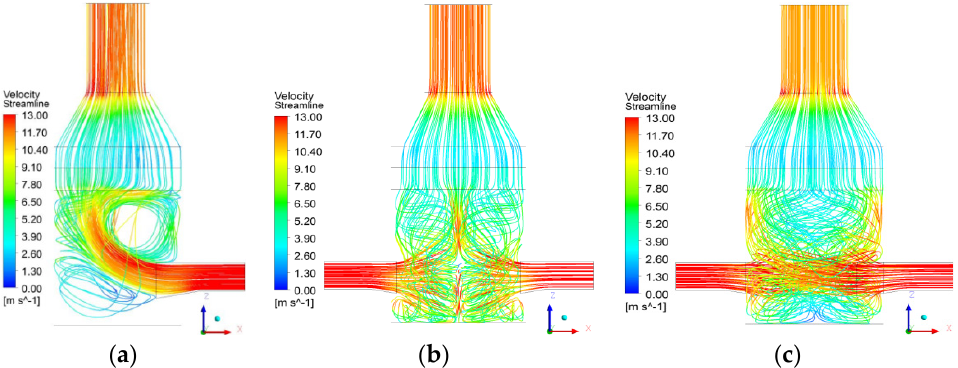
Figure 4. The gas phase streamlines without spray; ( a ) Single inlet; ( b ) Straight dual inlet; ( c ) Tangential dual inlet.